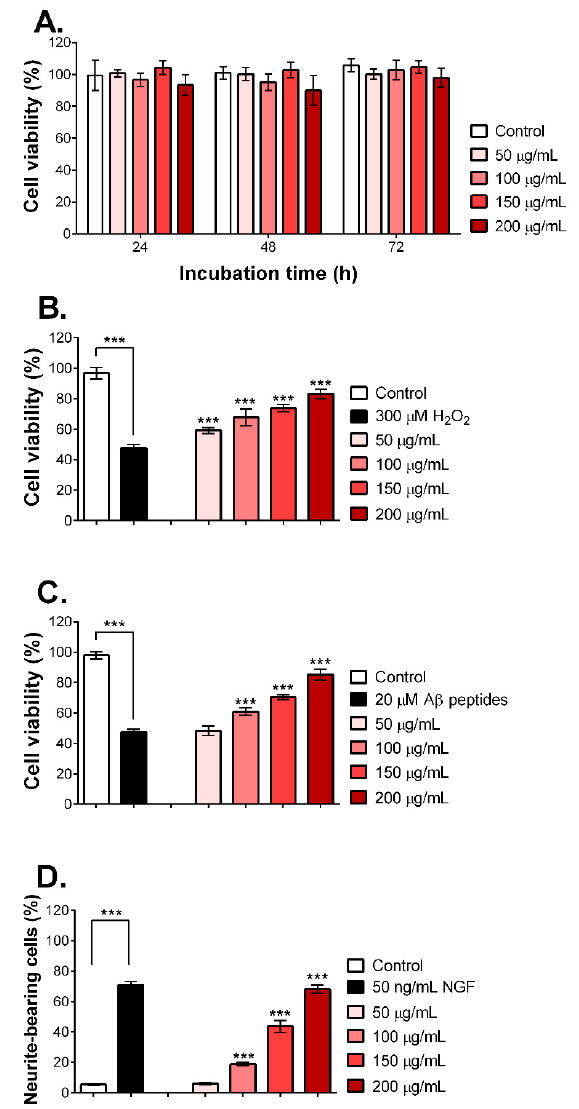
Figure 1. ( A ) Determination of safe doses of MNCM extract on the cell viability of PC12 cells after 24, 48, and 72 h of MNCM extract treatment, the percentage of cell viability is displayed. ( B ) Preventive e ff ects of MNCM extract on H 2 O 2 -induced cell death, cells were pre-treated with the extract (50–200 µ g / mL) for 24 h, then 300 µ M of H 2 O 2 was added for another 24 h. The percentage of cell viability is illustrated. ( C ) Preventive e ff ects of MNCM aqueous extract on A β peptide-induced cell death, cells were pre-treated with MNCM extract (50–200 µ g / mL) for 24 h, then 20 µ M of A β peptides were added for another 24 h. The percentage of cell viability is illustrated. ( D ) E ff ects of MNCM extract (50–200 µ g / mL) on neurite outgrowth compared with the nerve growth factor (NGF, 50 ng / mL). The data are represented as the percentage of neurite-bearing cells. The bar graphs are representative of three experiments and show mean ± standard deviation (SD). The one-way ANOVA followed by Tukey’s test was used to determine the di ff erences between groups. ***, p < 0.001.